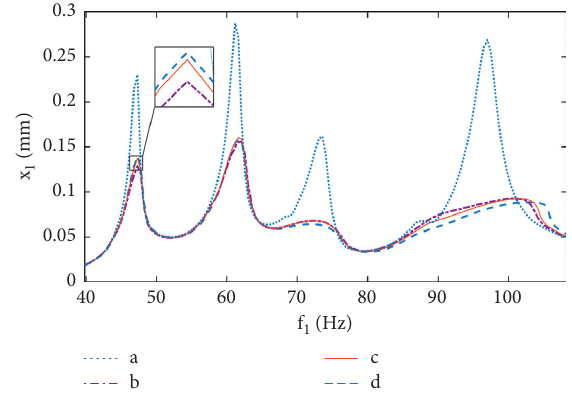
Figure 14: Amplitude-frequency curves when two SFDs are implemented on the front bearings of the low- and high-pressure shafts with different sets of clearances (a: no SFD, b: 0.22mm and